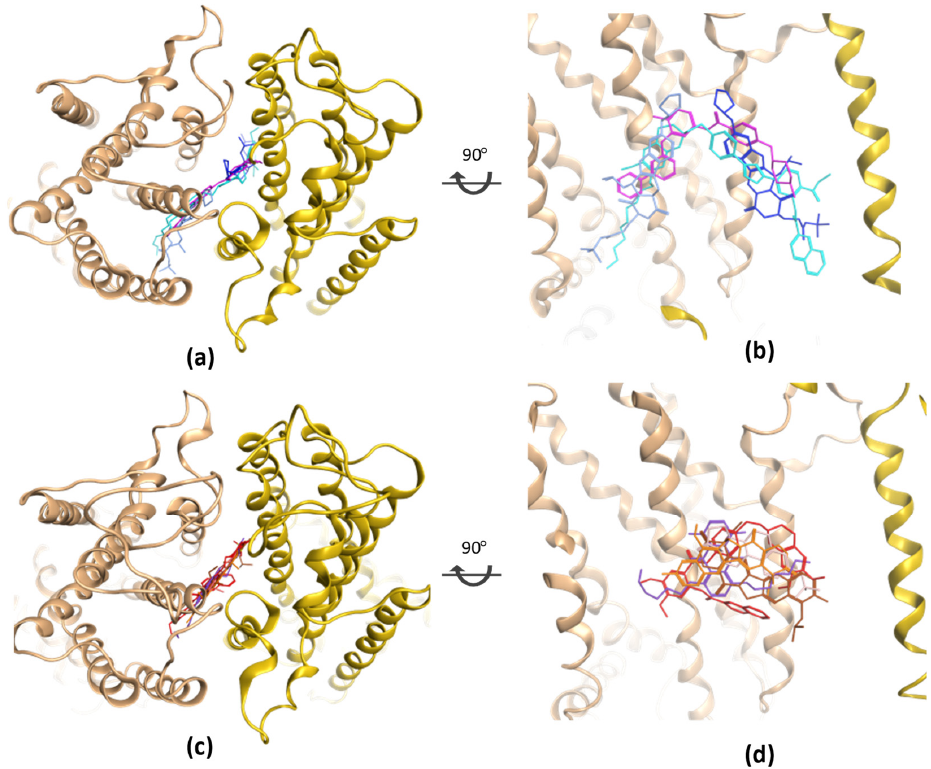
Figure 4. Superposition of bound inhibitors and substrates in the cavity center of ABCG2 cryo-EM structures. ( a ) Inhibitors MZ29 × 2 (in light and dark blue), MB 136 (in cyan), and imatinib (in rosa) from different PDB structures 6ETI, 6FEQ, 6VXH overlay in the same cavity center. ( c ) Overlay of 5 substrates in the cavity center of multiple ABCG2 cryo ‐ EM structures, namely SN38 (in orange, from 6VXJ), E1S (in pink, from 6HCO), tariquidar (in red, from 7NEQ), topotecan (in brown, from 7NEZ), and mitoxantrone (in violet, from 6VXI). ( b ) and ( d ) are the cross ‐ section view of ( a ) and ( c ), respectively.